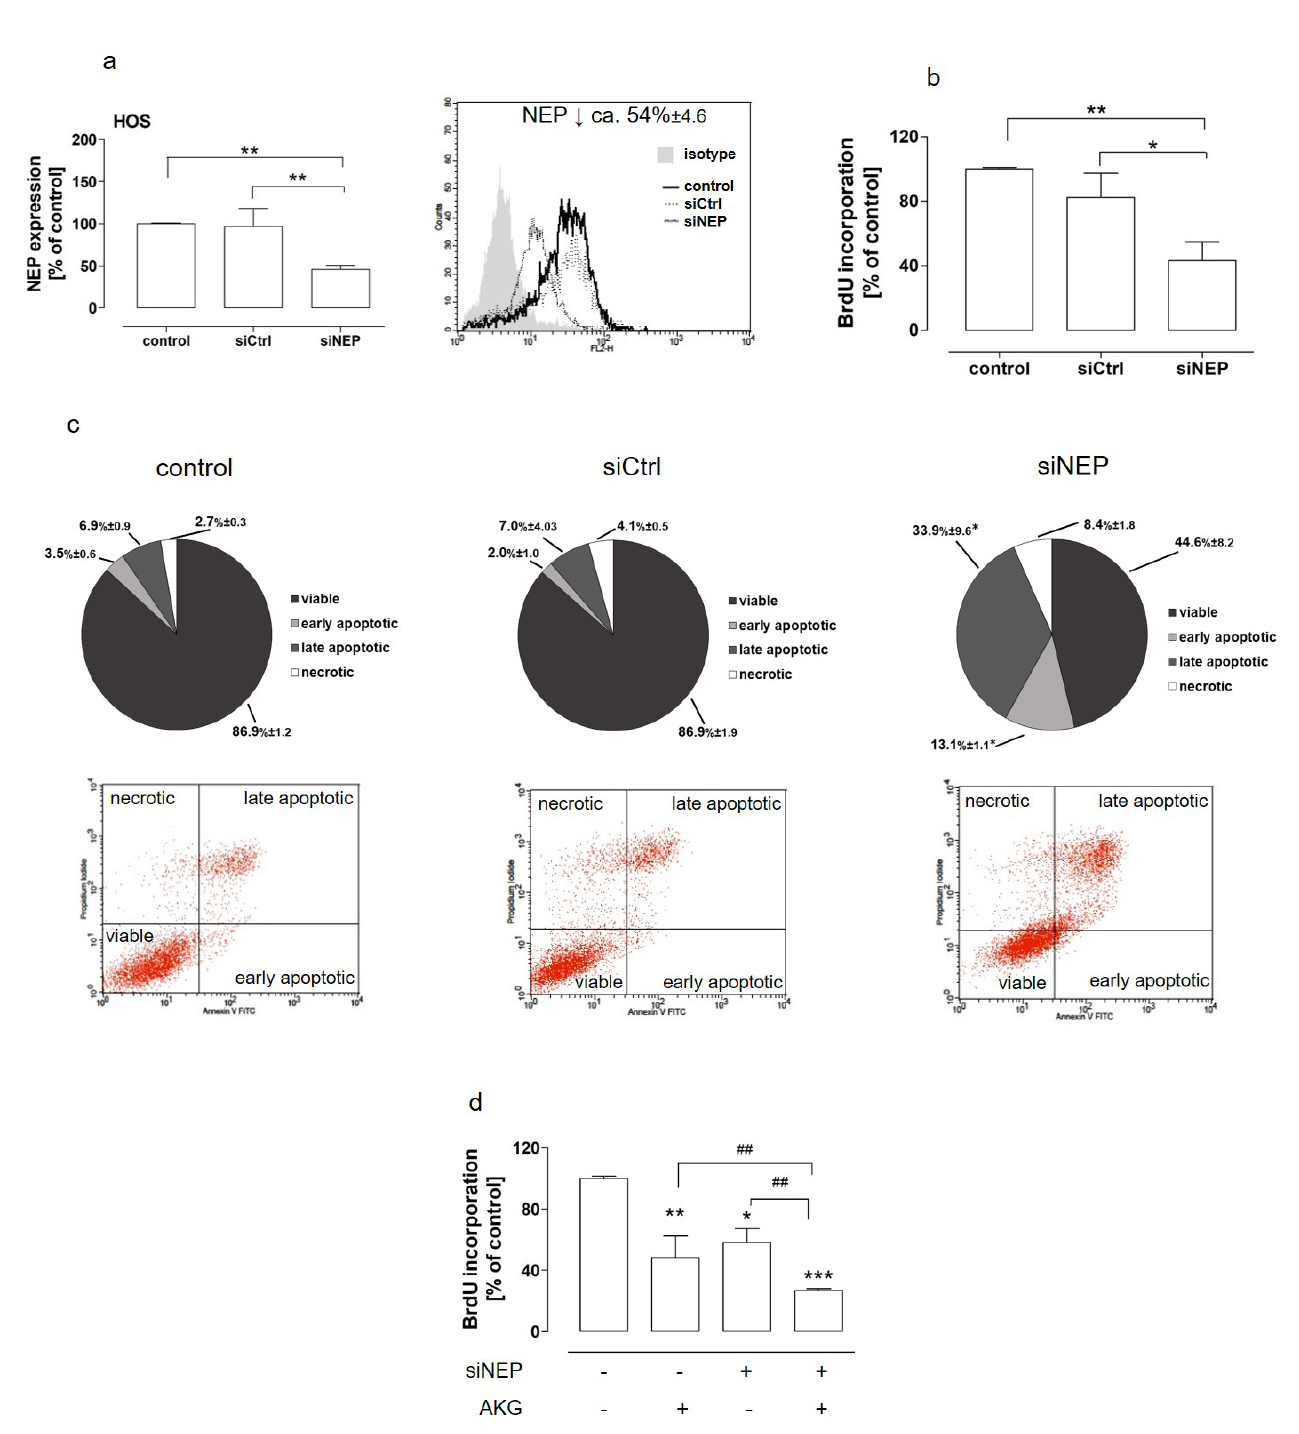
Figure 5. NEP was implicated in growth and in the AKG-mediated antiproliferative effects towards osteosarcoma cells. The level of NEP knockdown in the HOS cells was determined by flow cy- tometry ( a ). The proliferation and apoptosis of the NEP-expressing (control and siCtrl) and NEP- silenced (siNEP) HOS cells were examined by means of BrdU ( b , d ) and flow cytometry assays after AnnexinV-FITC/propidium iodide staining ( c ), respectively. The cells were treated with 50 mM AKG. Isotype—control, NEP-positive cells stained with PE-conjugated mouse IgG1 isotype control, control— siRNA-untreated NEP-positive cells, siCtrl—negative siRNA-treated cells, siNEP—NEP-silenced